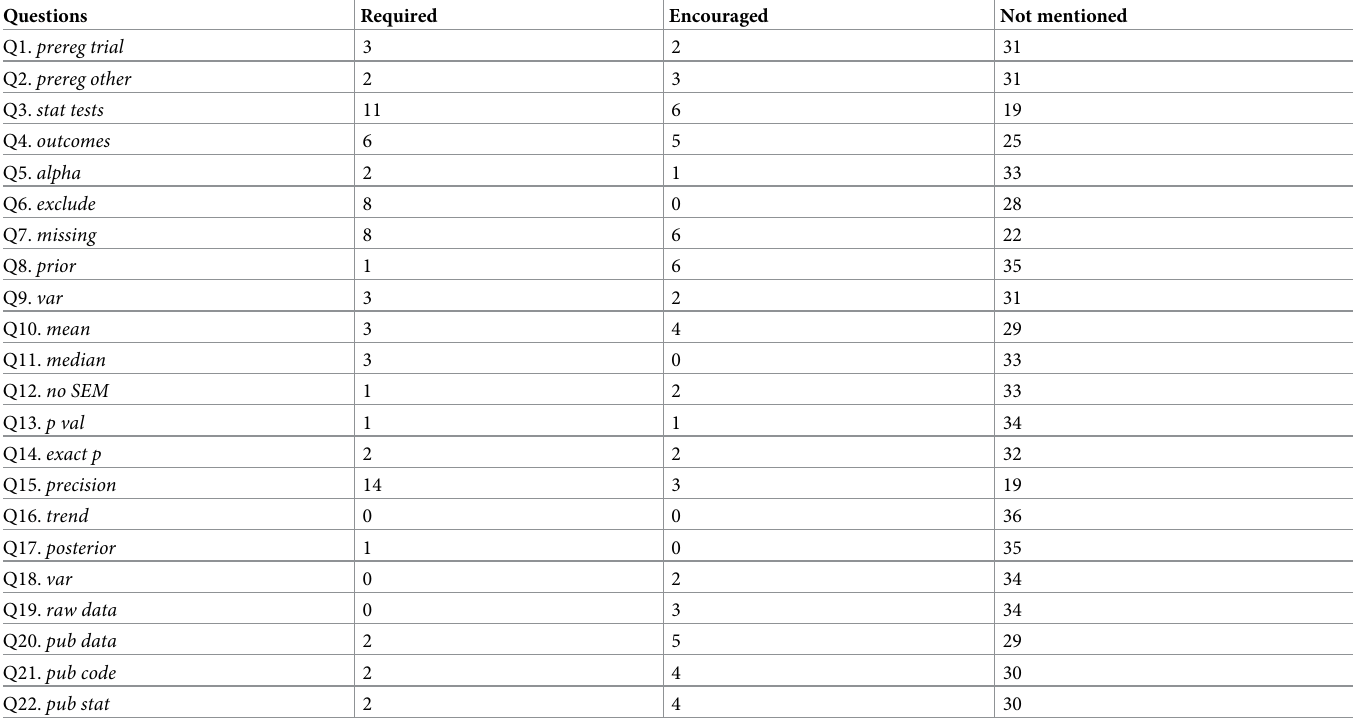
Table 2. Summary results across the 36 external guidelines and checklists referenced by journal Instruction to Authors . Values represent the number of external guide- lines and checklists that required, encouraged or did not mention audit question items. Question names refer to those defined in Table 1. Audit results for each external guideline and checklist are provided in S2